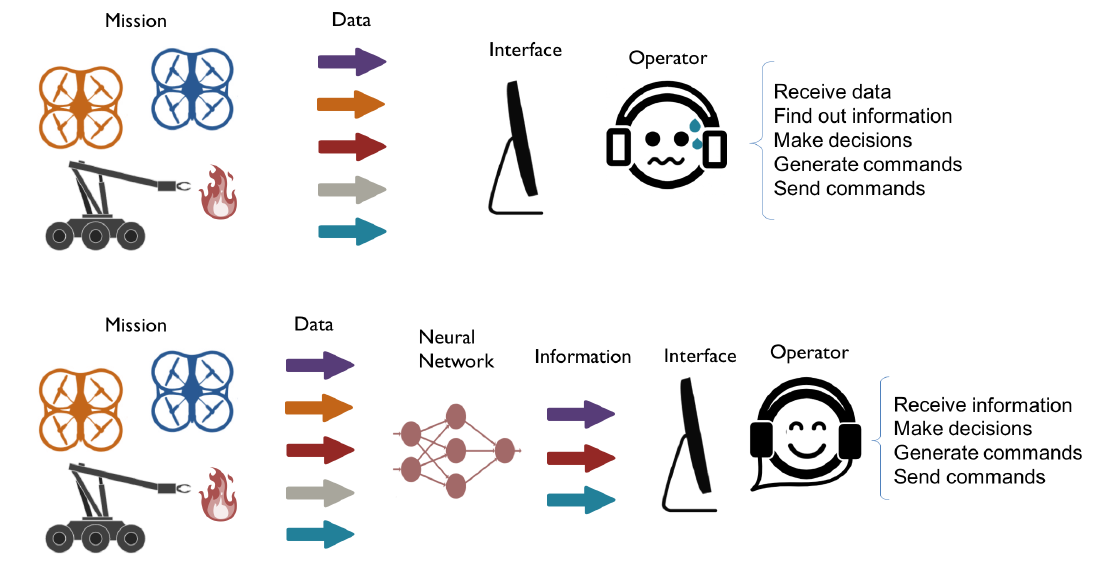
Figure 2. Contribution of prediction to interfaces. ( upper ) The operators of non-predictive interfaces have to receive data, find information, make decisions, generate commands and send them. ( lower ) Predictive interfaces can help the operators performing some functions such as the discovery of